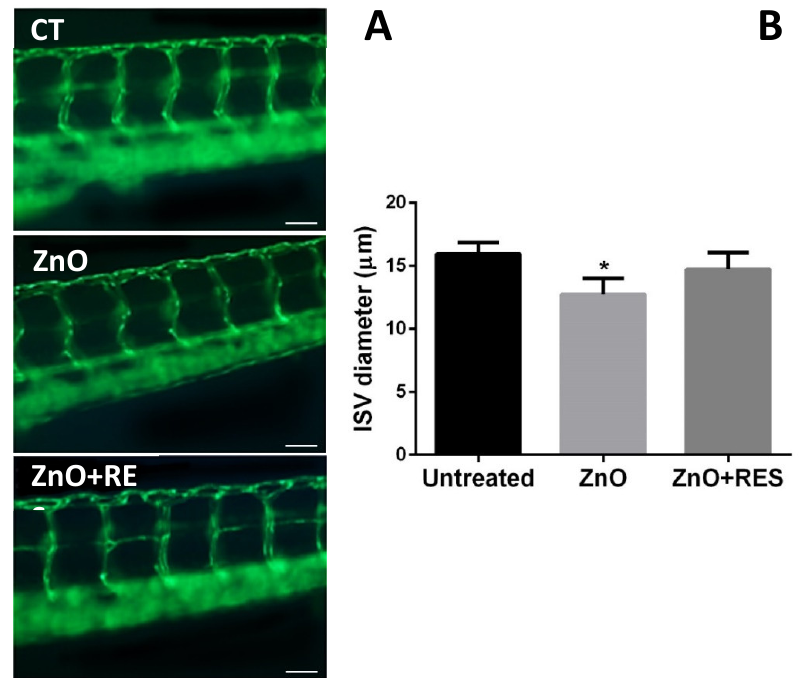
Figure 9. Resveratrol ameliorates alterations in the width of intersegmental vessels. ( A ) Representative fluorescence pictures depicting intersegmental vessels (ISVs) in the 96-hpf Fli1-GFP embryos exposed to 3 mg/L ZnO-NPs (ZnO) indicting a reduced vessel width as compared to the dimension of the control group (CT). Embryos exposed to 3 mg/L ZnO + 5 μM resveratrol (ZnO + RES) display a decrease in the incidence of modified vessels, which appear both regular and with reduced NP-induced phenotype modification. Scale Bar 50 μM. ( B ) Quantification of vessel diameter was performed using ImageJ (v1.44 public domain software http://rsbweb.nih.gov/ij/) in 96 hpf embryos. RES, resveratrol. Values are shown as mean ± SD, n = 20. *, significantly di ff erent from the untreated. (Magnification 20 ×